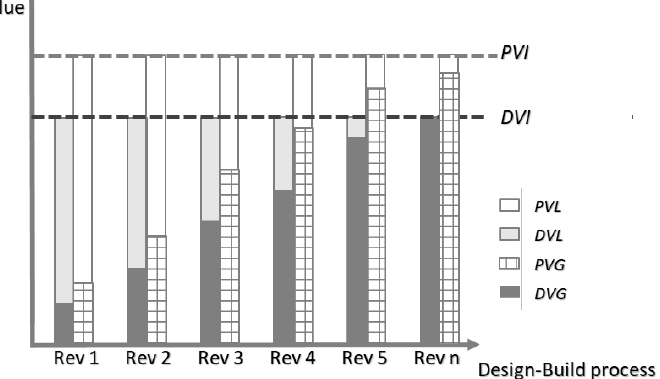
Figure 2. Value evolution [20].